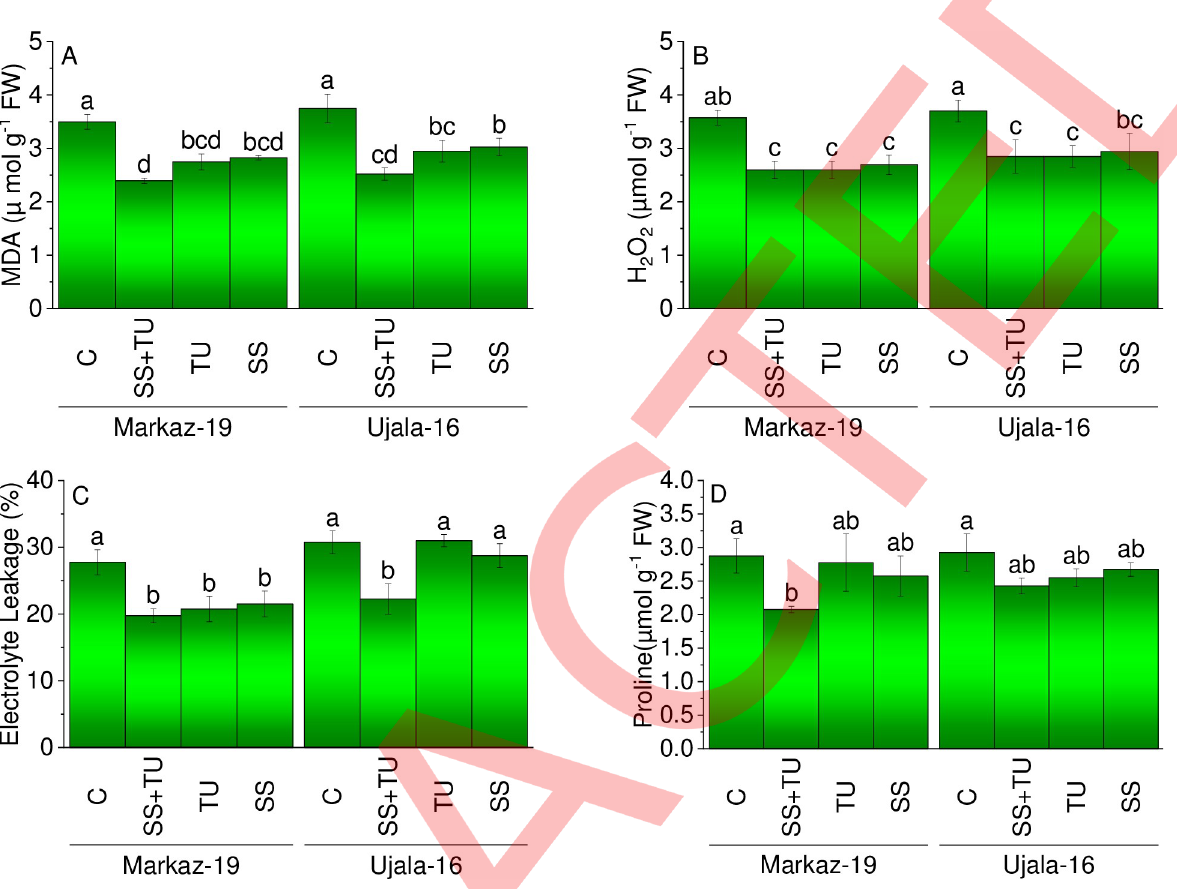
Fig 4. Impact of different treatments on MDA (A), H 2 O 2 (B), EL (C) and proline contents (D) of two wheat genotypes (Markaz 19 and Ujala 16) after 35 d of the growth period in pots. All values are the mean of 4 replicates. Error bars are showing ± standard error. Different letters on bars are significantly different at p < 0.05 according to LSD test. C: Control, SS+TU: sewage sludge+thiourea, TU: thiourea, SS: sewage sludge.